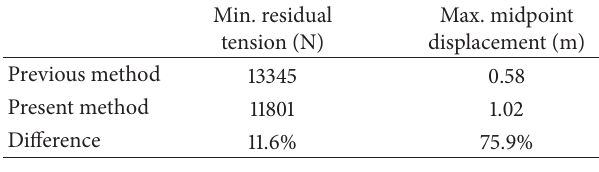
Table 3: Comparison of simulation results.